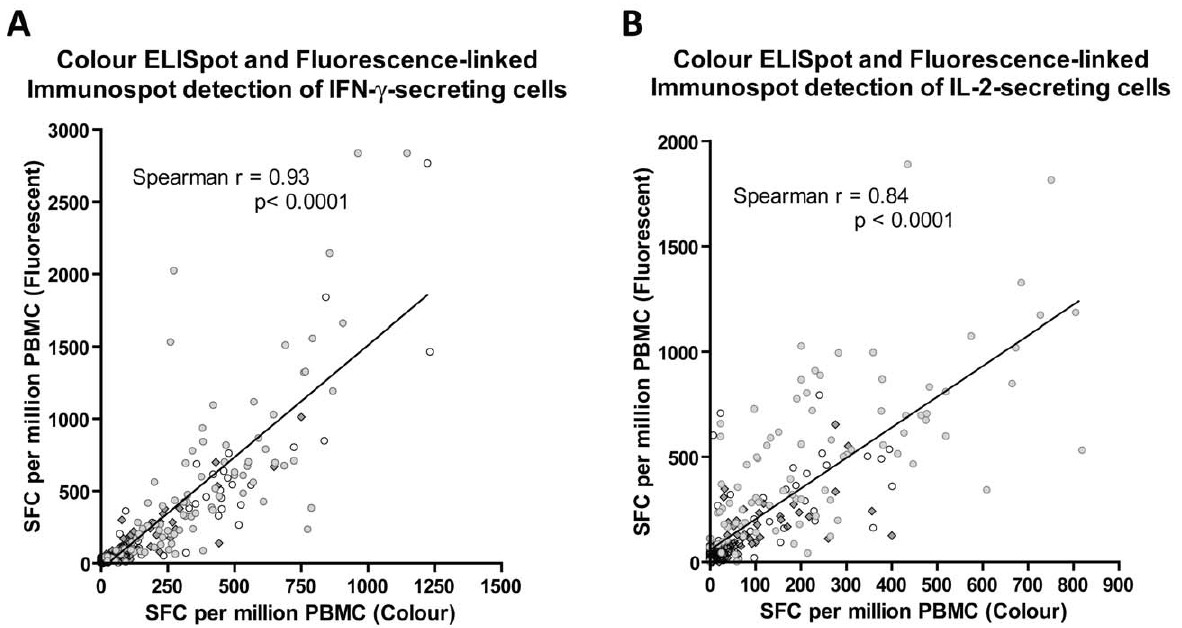
Figure 2. Comparison of the number of antigen-specific spot-forming cells (SFC) detected by fluorescence-immunospot and colour ELISpot. PBMC from 90 independent samples from 76 donors were stimulated with PPD (diamonds), ESAT-6 (hollow circles) or CFP-10 (grey filled circles). IFN- c (A) or IL-2 producing cells (B) were enumerated by colour ELISpot and fluorescence-immunospot. Correlation between results of the 2 tests was tested by Spearman’s rank correlation. Responses to PPD and peptide pools of ESAT-6 and CFP-10 were each strongly correlated between the colour and fluorescent assays for enumerating IFN- c -secreting cells (r=0.89 CI: 0.83–0.94, r=0.89 CI: 0.9–0.95, r=0.83 CI: 0.72–0.90 for PPD, ESAT- 6 and CFP-10 respectively) and IL-2-secreting cells (r=0.84 CI: 0.73–0.90, r=0.73 CI: 0.56–0.84, r=0.70 CI: 0.53–0.82 for PPD, ESAT-6 and CFP-10 respectively).